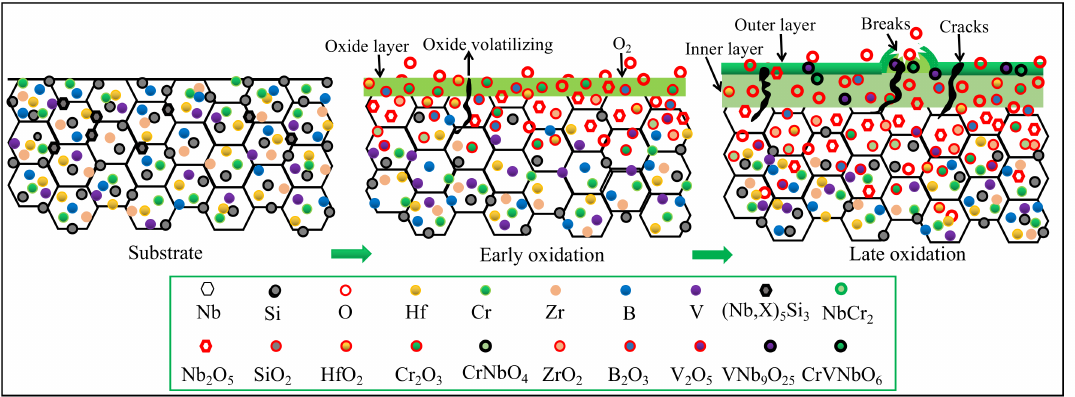
Figure 15. Schematic diagram of oxidation behavior and failure mechanism of Nb-Si-based